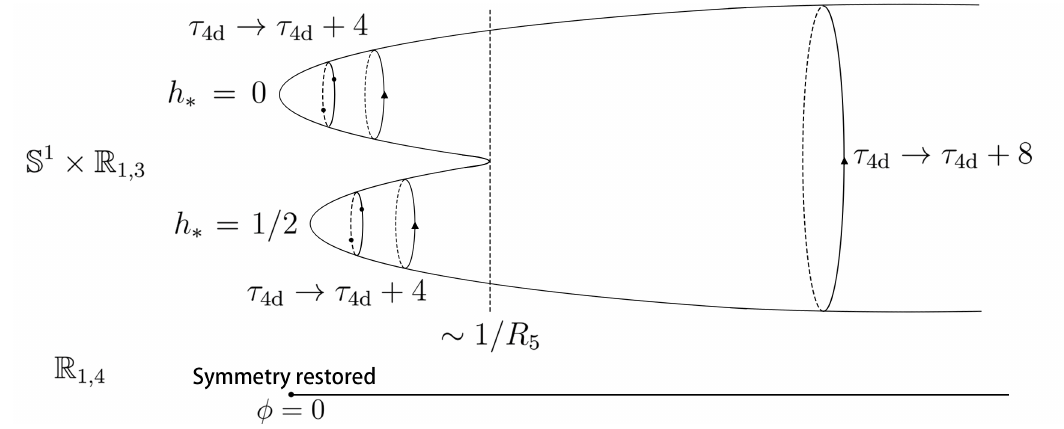
Figure 15 . Moduli space for F1-theory with positive coupling-squared. A pair of 4d Seiberg- Witten geometries, or holonomy saddles, reside to the left of the scale ∼ 1 /R point in the decompactification